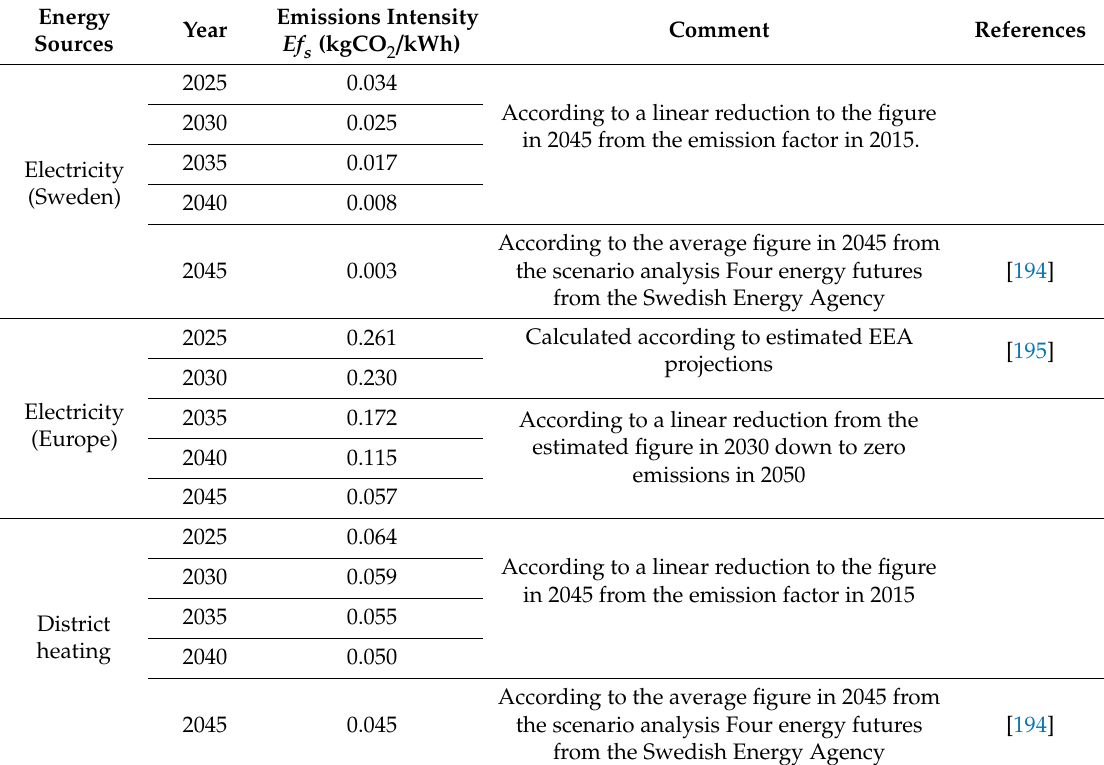
Table A3. Predicted emissions intensity factors for electricity and district